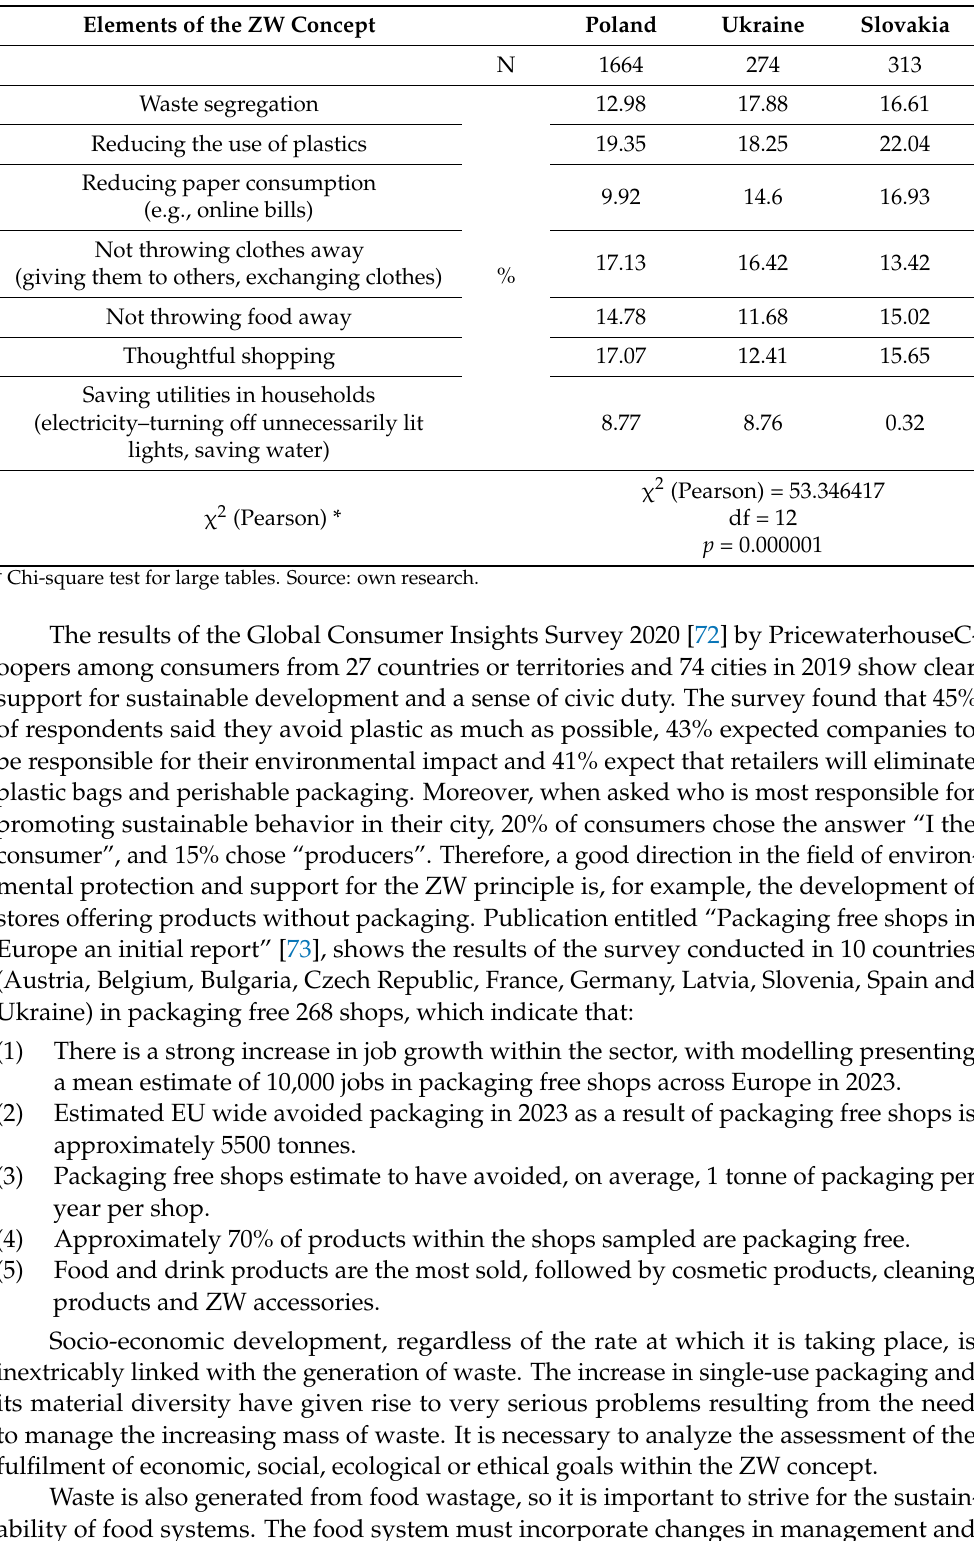
Table 7. Elements identified with the ZW concept by respondents from Poland, Ukraine and